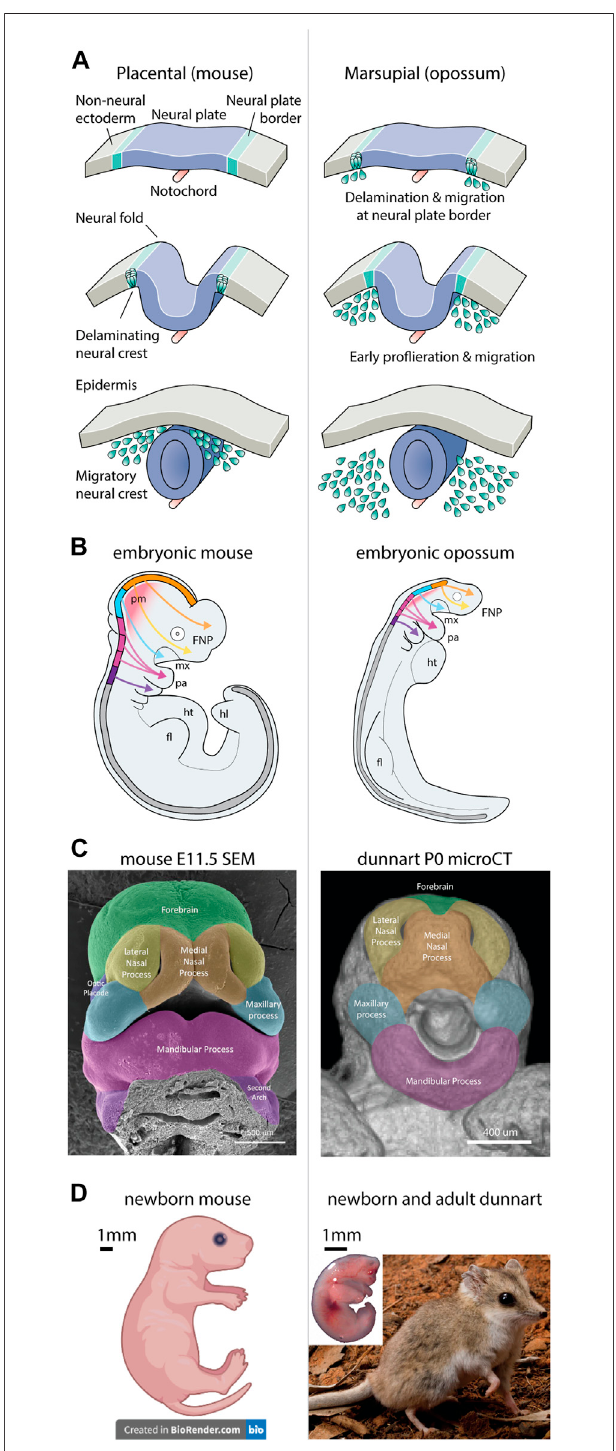
FIGURE 1 | Neural crest and craniofacial development between therian mammals. Craniofacial heterochrony between therian mammals arises from altered neuralcrestcellbehaviours. (A) Inplacentalmammals,theneuralcrest forms intheneural foldsand delaminates fromtheneuraltube tomigrate throughout the embryo. In marsupials however, the neural crest forms and delaminates from the neural plate border, leading to accelerated migration in ( Continued )